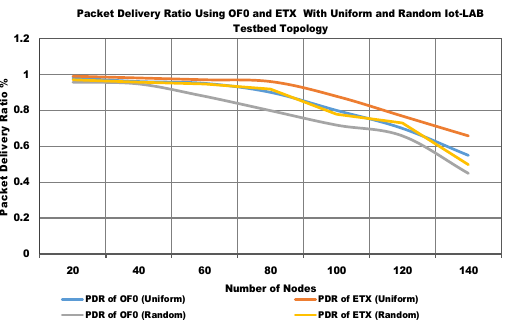
Figure 10. Comparison between packet delivery ratio in IoT‐LAB testbed using OF0 and ETX with random and uniform network topology.